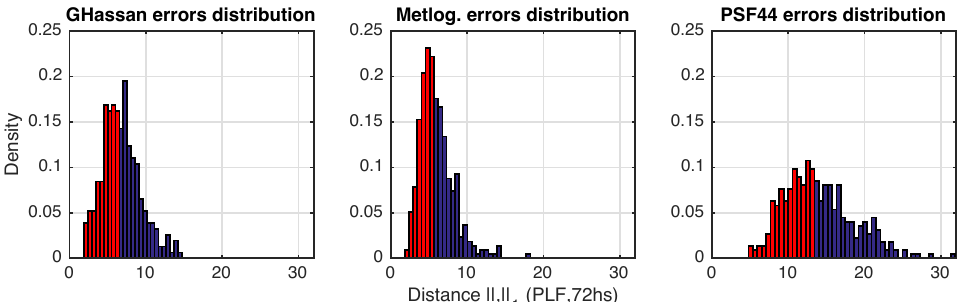
Figure 5. Histograms for total deviations of forecasts within a horizon of 72 h ahead. Red and blue areas concentrate 50% of probability in all cases [leftmost: Garrad Hassan, center: Meteológica, rightmost: PSF44].